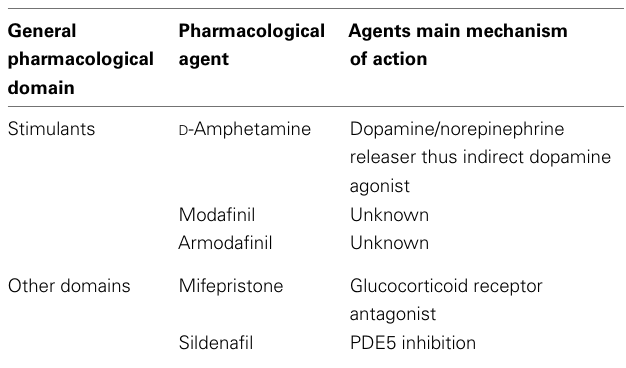
Table 1 | Pharmacological agents used and their main mechanism of